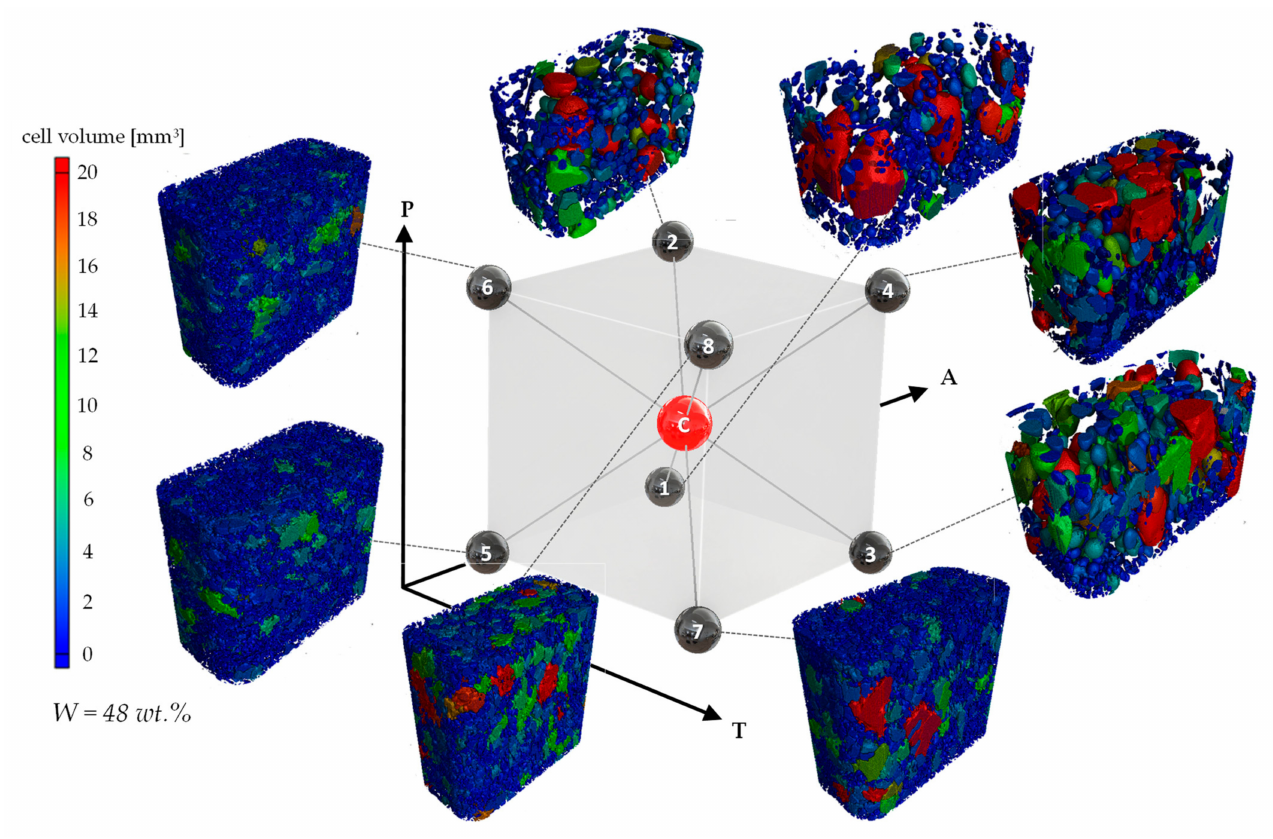
Figure 9. Cell volume of samples 1–9 for W48 (no. 1–4 degassed, no. 5–9